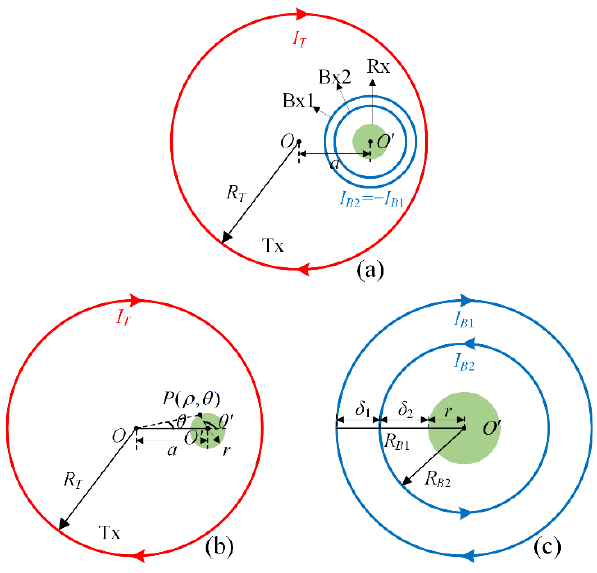
Figure 5. Design principle of eccentric dual bucking model. ( a ) the overall spatial distribution of each submodule in this model. ( b ) the magnetic flux at the receiving area of the transmitting coils. ( c ) the magnetic flux at the receiving area of the bucking